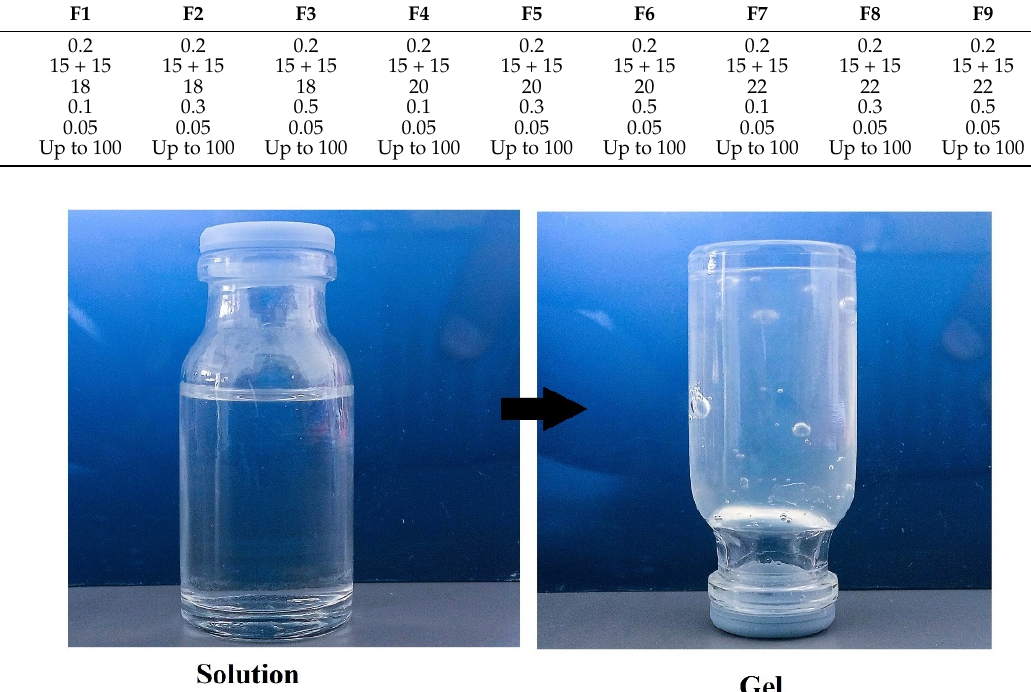
Table 1. Compositions of preliminary batches of nasal in situ gel of darunavir.